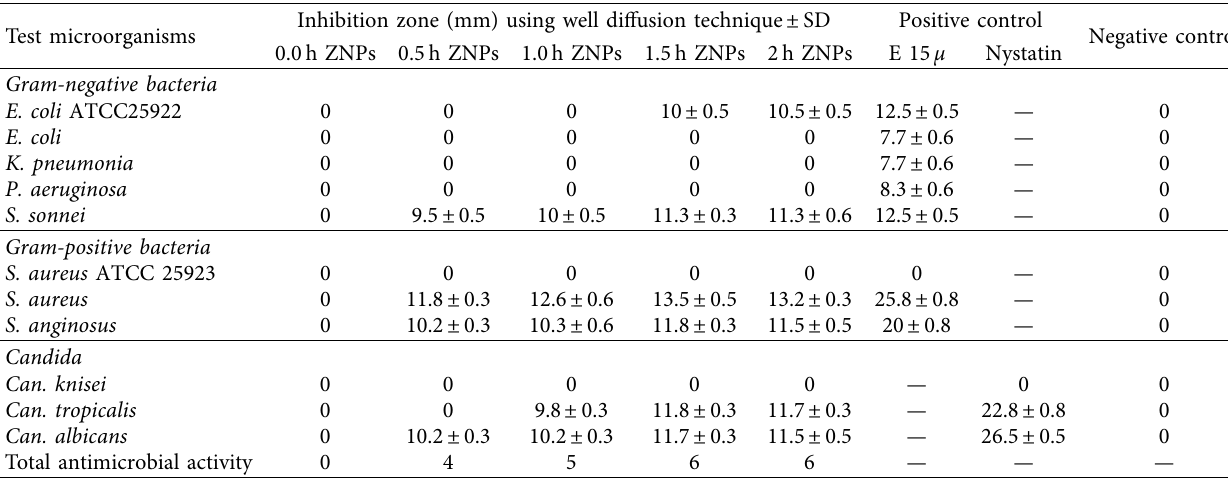
Figure 8: Antimicrobial activity of ZNPs at diferent milling times: b, 0h; c, 0.5 h; d, 1h; e, 1.5h; and f, 2h; and a, negative control; and g, positive control. Table 3: Antimicrobial activity of ZNPs against some pathogenic bacteria and yeasts using well difusion